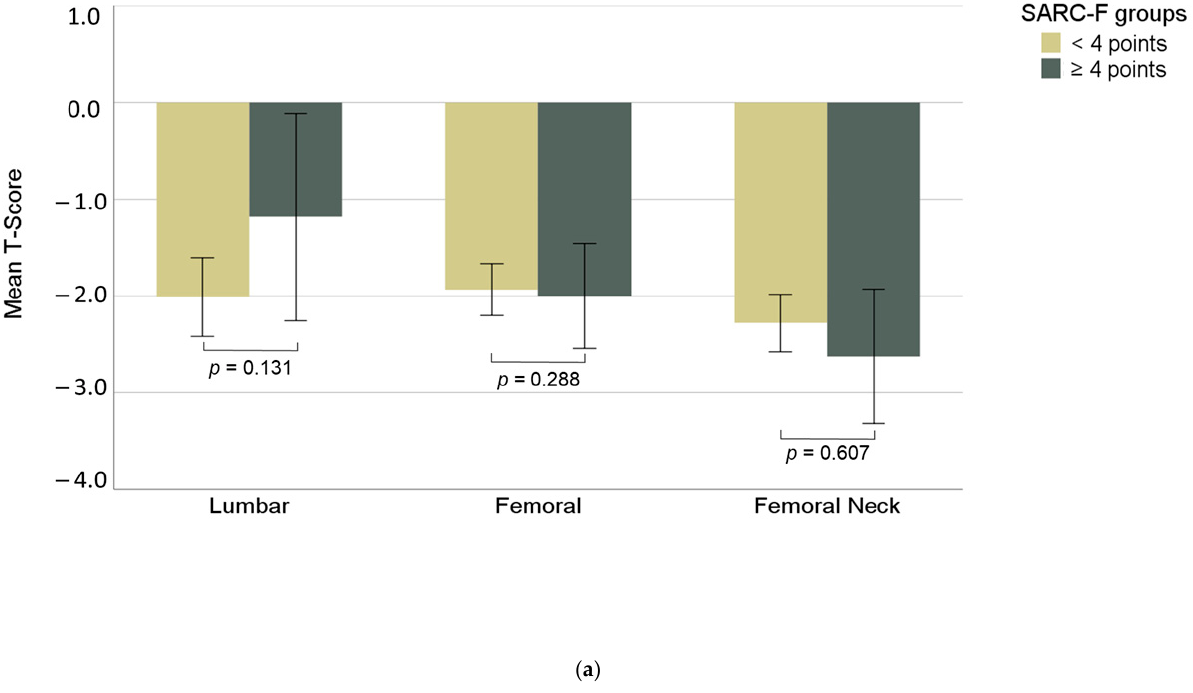
( b ) Figure 3. ( a,b ): differences between T-scores for different scores in MNA-SF and SARC-F questionnaires, respectively. 4. Discussion This study sought to evaluate a potential added value of including two well-estab- lished screening questionnaires for sarcopenia (SARC-F) and malnutrition (MNA-SF) into